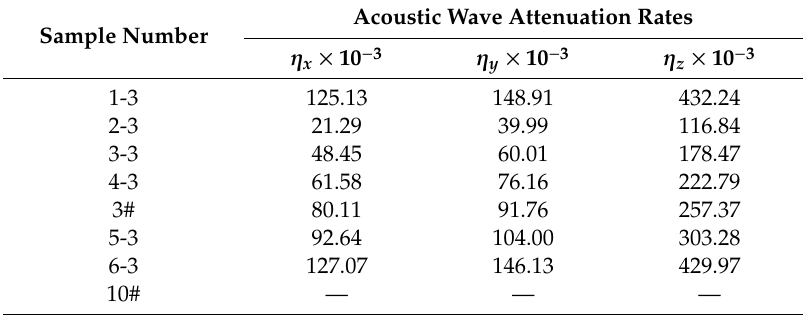
Table 4. WVA rates of coal samples under varied confining pressures after three periods of liquid nitrogen